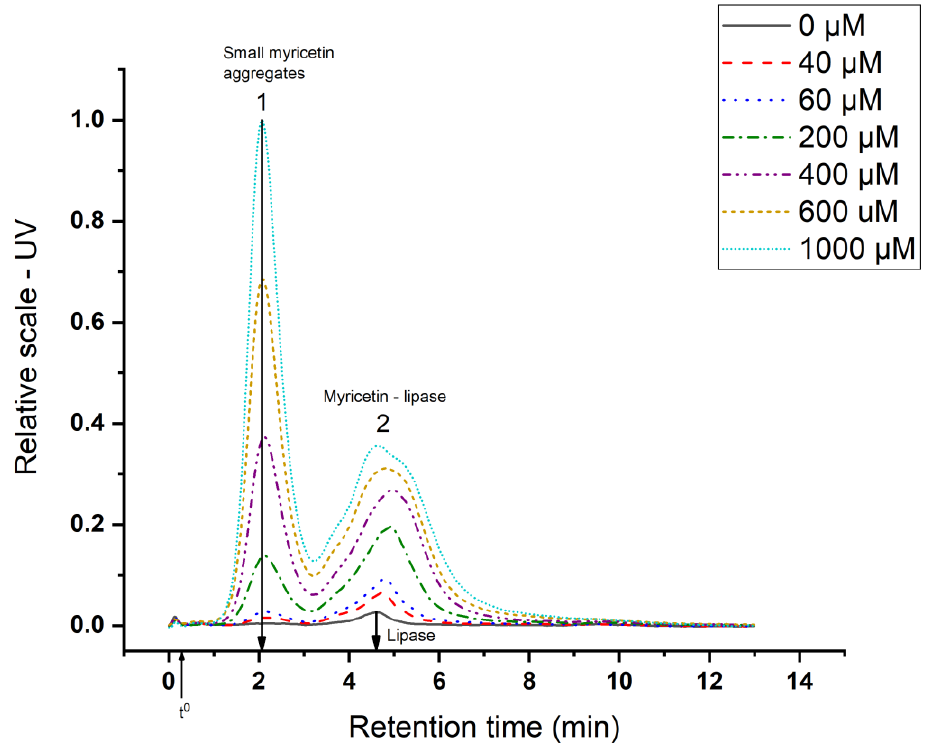
Figure4. AF4–UVfractogramofdi ff erentconcentrationsofmyricetinwith0.5mg / mLlipase. Table0.sec. Figure 4. AF4 – UV fractogram of different concentrations of myricetin with 0.5 mg/mL lipase. Table 0. sec.